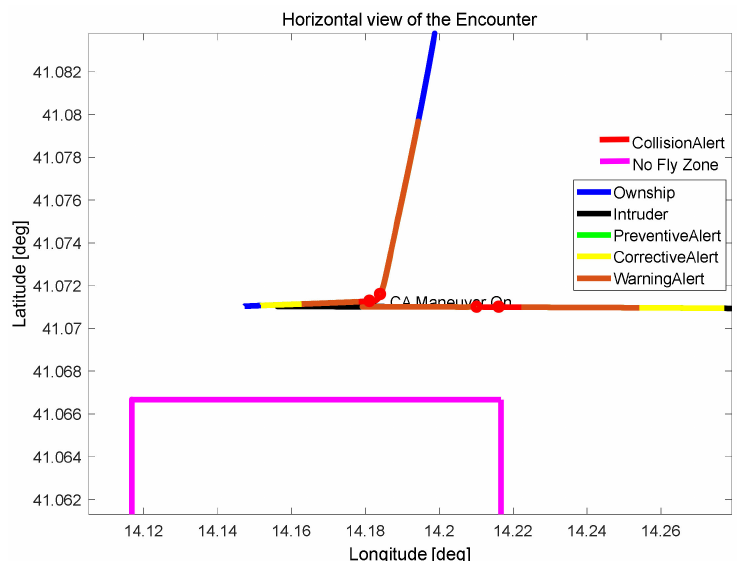
Figure 18. Horizontal trajectory of the head-on encounter.